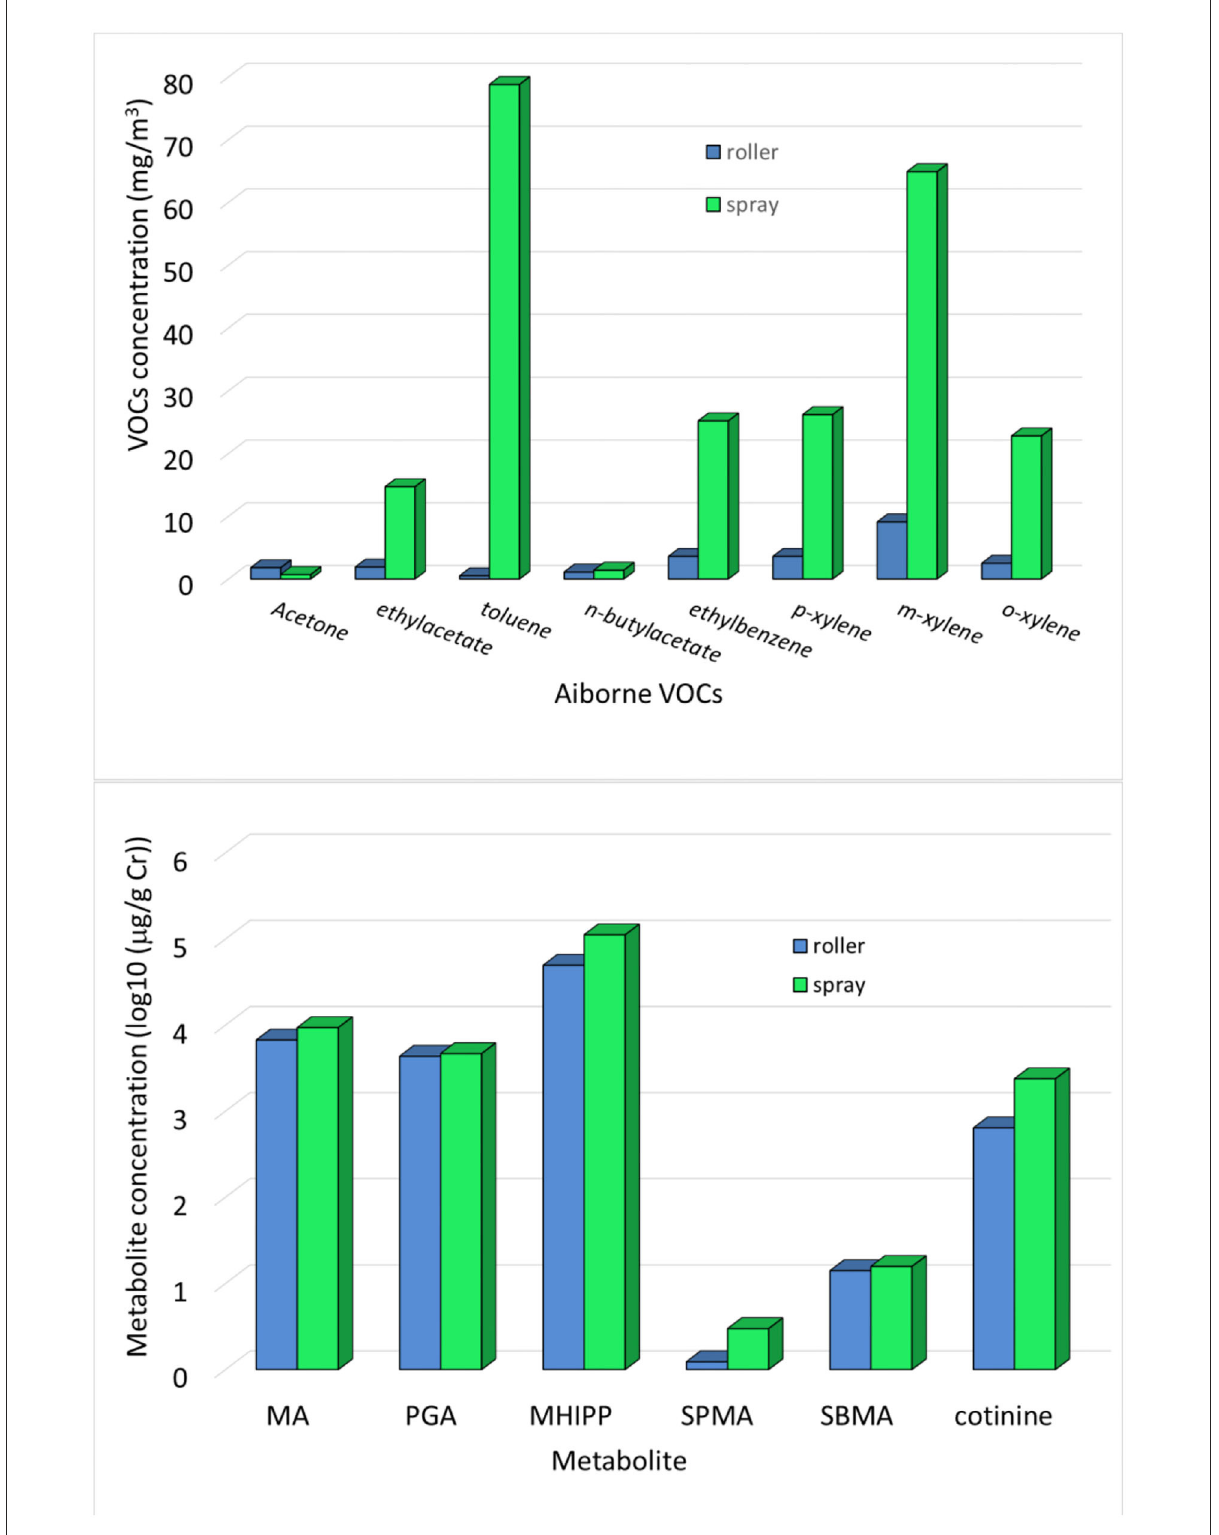
FIGURE1 (Top) Airborne VOC concentrations and (bottom) metabolite concentrations measured in the end shift urine in the groups of roller and spray painters. To compare very different quantities, the metabolite concentrations were